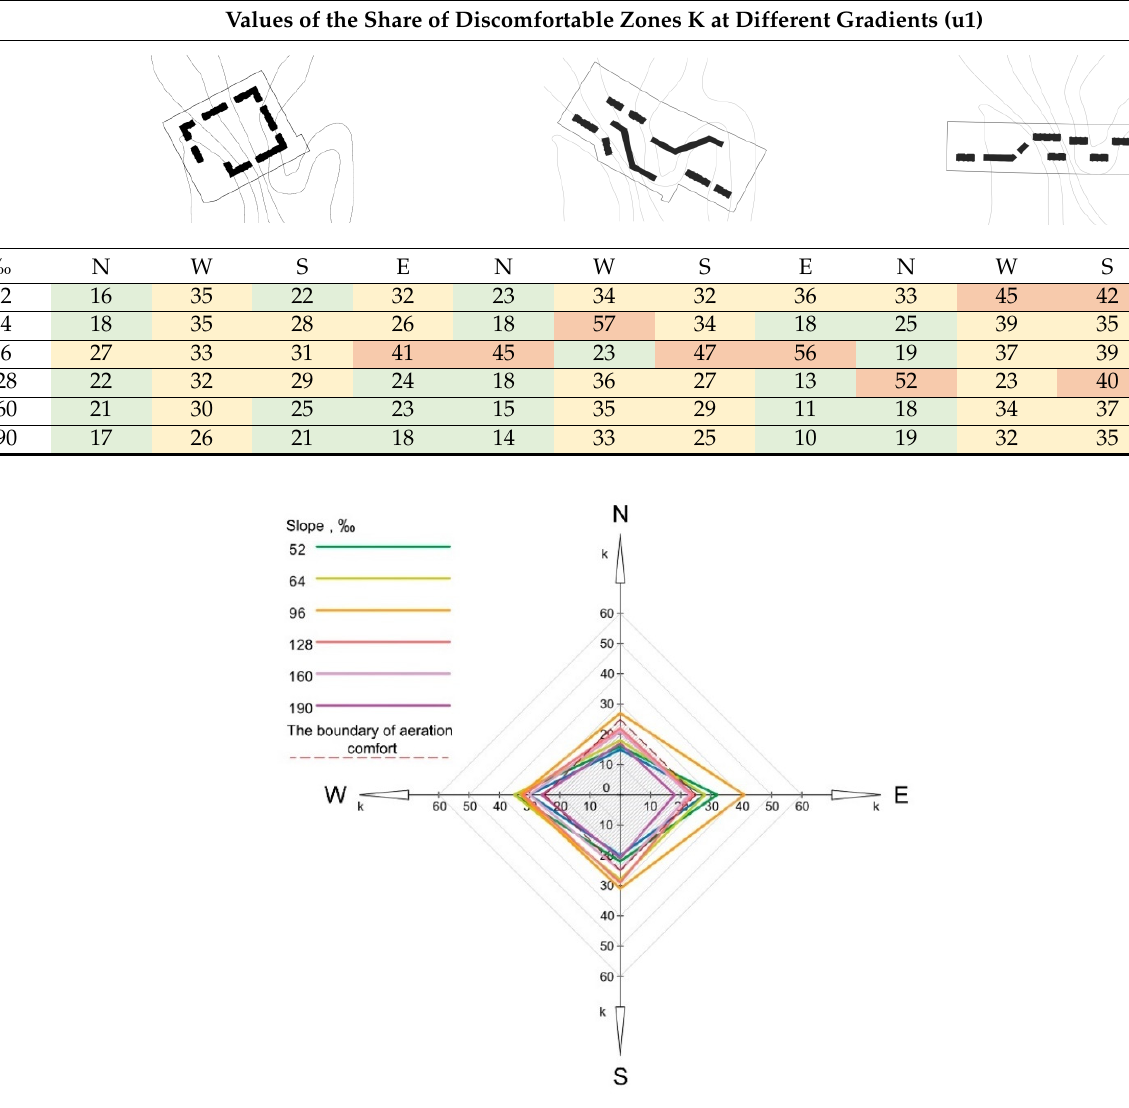
Table 5. Table of dependencies of the share of discomfortable zones on the gradient and morphotype of development.